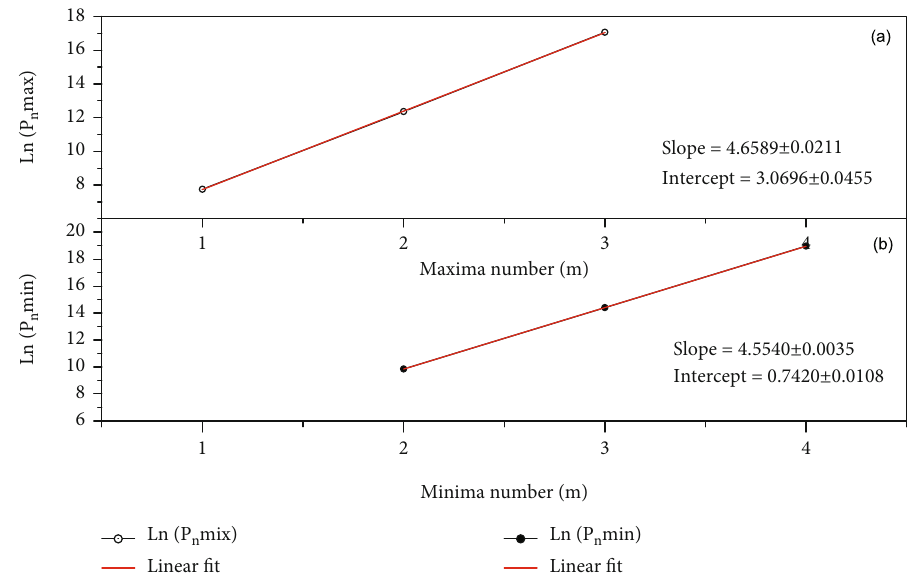
Figure 11: (a) The relation between the maxima, its maxima number ( m ), and its corresponding liner fi t. (b) The relation between the minima and its minima number and its corresponding liner fi t.